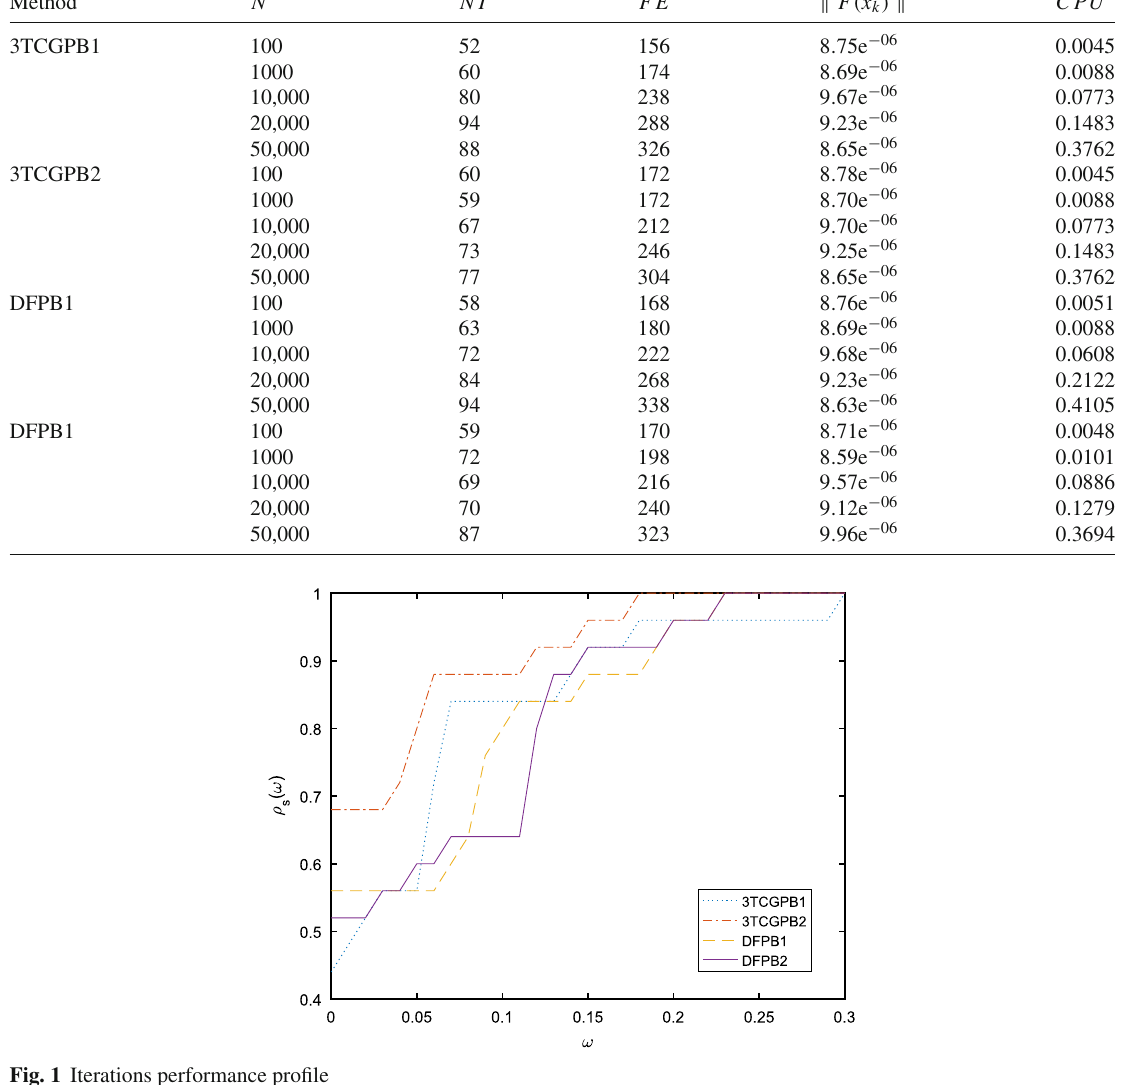
Fig. 1 Iterations performance